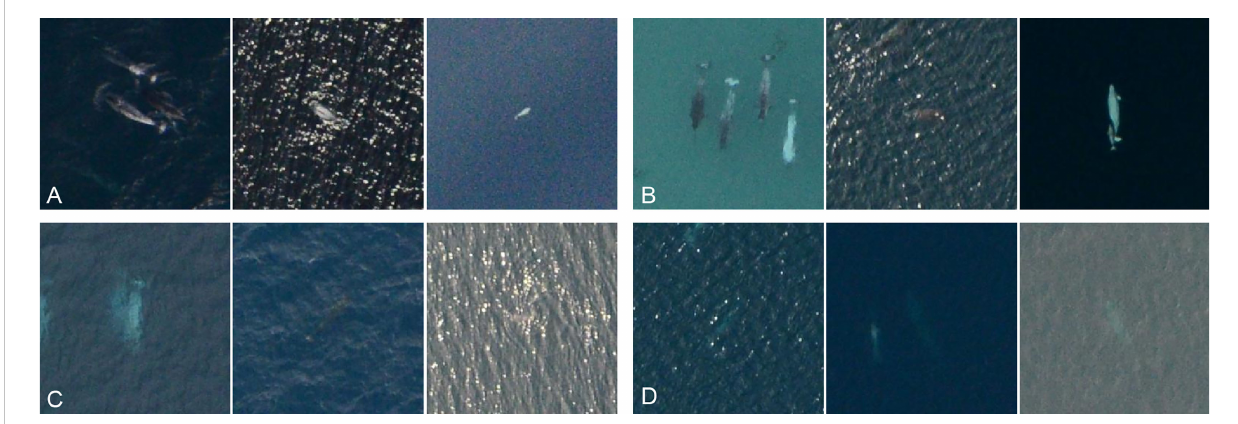
FIGURE 1 Examples of image diversity of belugas and narwhals in different environments and with varying estimated depths: (A) In surface waters, (B) Animals located between 0 and 1 meter from the surface, (C) Animals between 1 and 2 meters from the surface, (D) Animals deeper than 2